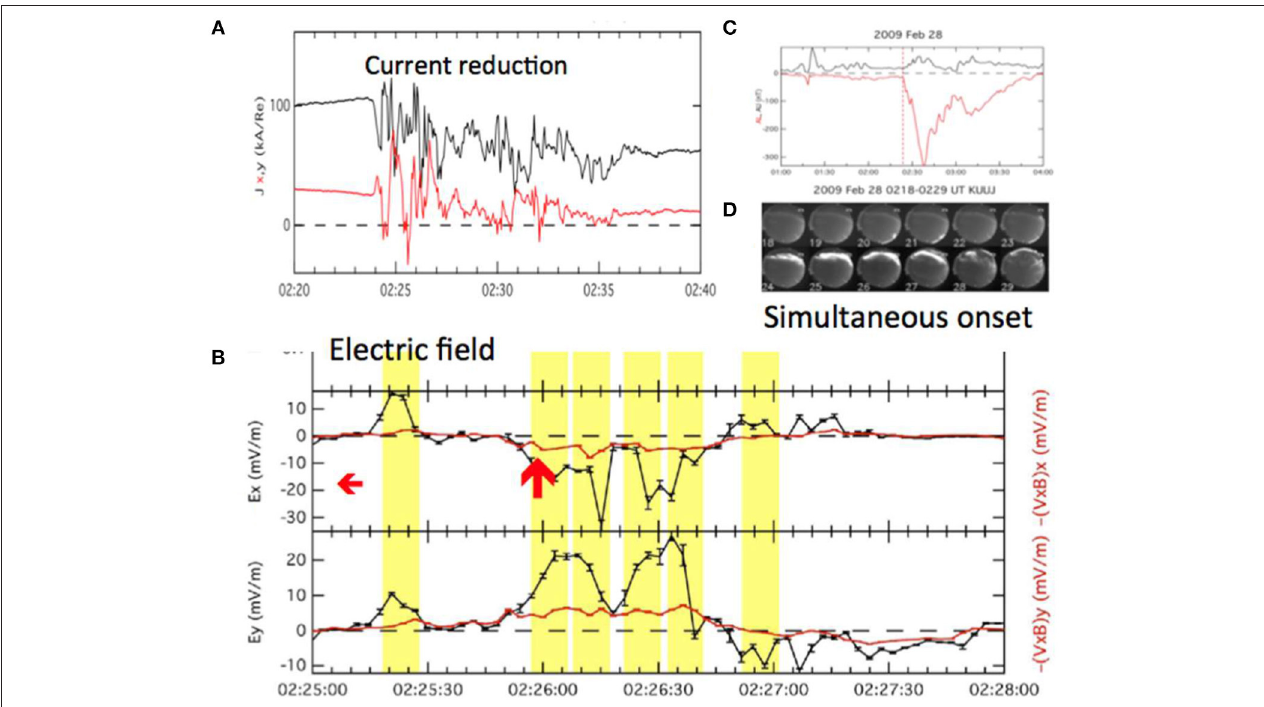
FIGURE 13 | (A,C,D) the current at 8.1 Re was decreased when an auroral substorm occurred as shown by a series of all-sky images and by the occurrence of a negative change of the field (the development of the auroral electrojet). (B) a satellite observation at 8.1 Re, showing the growth an earthward electric field ( E x) of 30 mV/m. The figure shows also that the condition of ( E + V x B = 0) (the frozen-in field condition) broke down; the difference between the black and red lines indicates how much the frozen-in field condition is broken